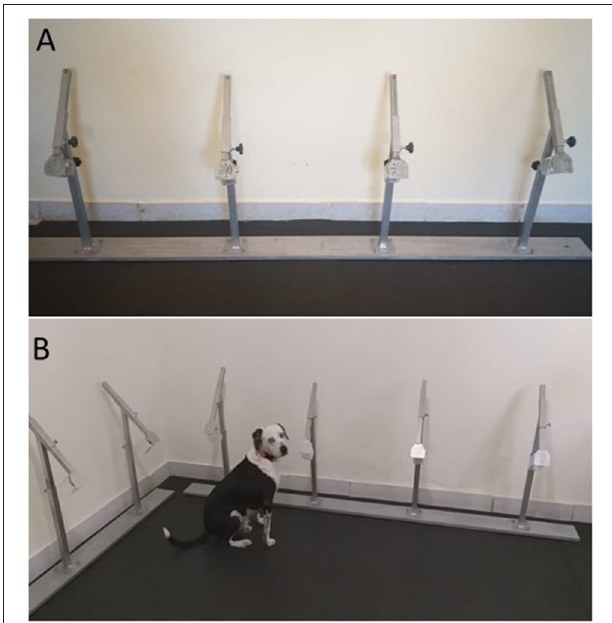
FIGURE 2 | The experiment of olfactory detection by dogs. (A) Testing line of samples. (B) Male dog, Sinatra, indicating the positive sample by sitting in front of the